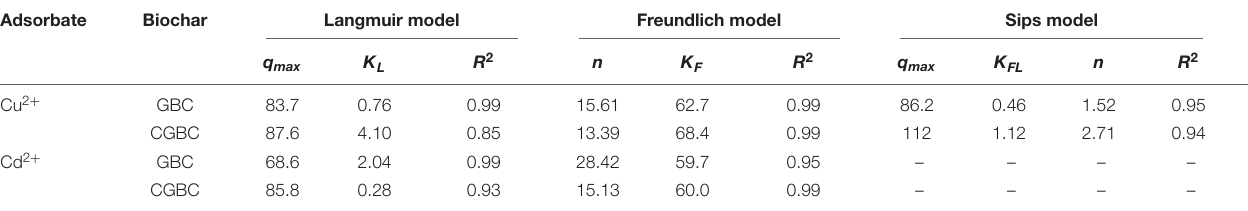
TABLE 4 | Isotherm parameters for adsorption of Cu 2 + and Cd 2 + on GBC and CGBC. Adsorbate